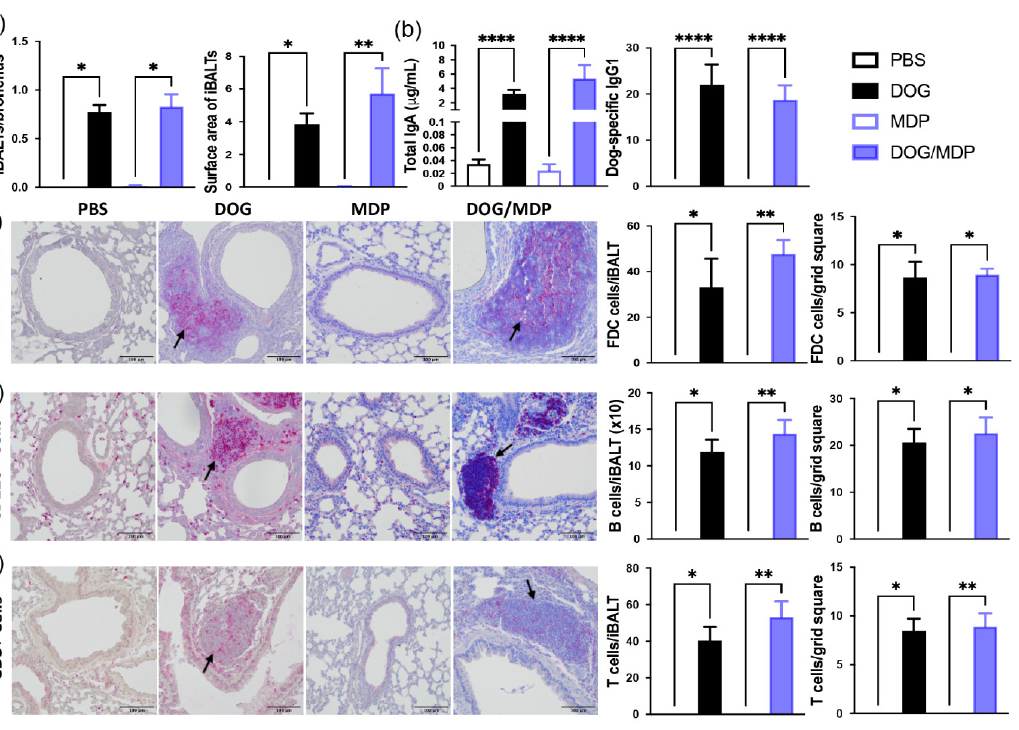
Figure 6. MDP does not aggravate the formation of iBALT. Representative microphotographs and quantification of iBALT. ( a ) Numbers and surface area (number of grid squares) of iBALT. ( b ) Levels of total IgA and dog ‐ specific IgG1 (as titers) in BAL. ( c – e ) Immunohistochemistry staining of FDC ( c ), B ( d ), and T ( e ) cells and counts and surface area per iBALT. Scale bars: 100 μ m. Positive cells are stained in red. Black arrows show staining of interest. Data are presented as mean ± SEM (n = 4–6 mice per group, with 3 to 9 different lung sections analyzed per mouse, for histology, and n = 9–18 mice per group for Ig). * p < 0.05, ** p < 0.01, **** p < 0.0001 versus PBS or MDP. Kruskal– Wallis test for all.